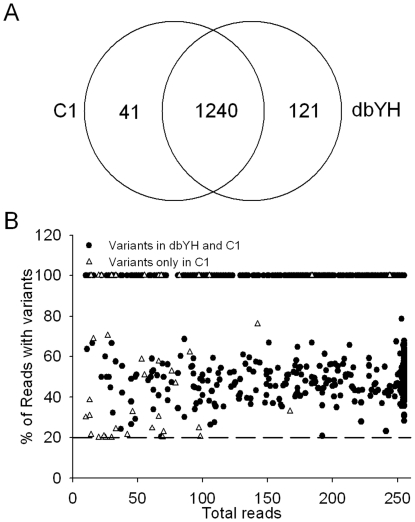
Estimation of the accuracy of Targeted DNA-HiSeq according to the following criteria: (1) sites are supported by at least 10 reads; (2) a variant sequence is supported by more than 20% of the total reads for a heterozygous genotype; and (3) a quality value of greater than 20 per base is obtained.(A) Venn diagrams of the number of variants in C1 as detected by Targeted DNA-HiSeq and in dbYH. Based on the reference genome, we found 1281 SNVs of 193 genes in YH DNA using Targeted DNA-HiSeq, of which 96.8% (1240/1281) were also identified in dbYH. (B) The distribution ratio of candidate variants in heterozygous genotypes between common variants (1240 variants) and specific variants (41 variants).